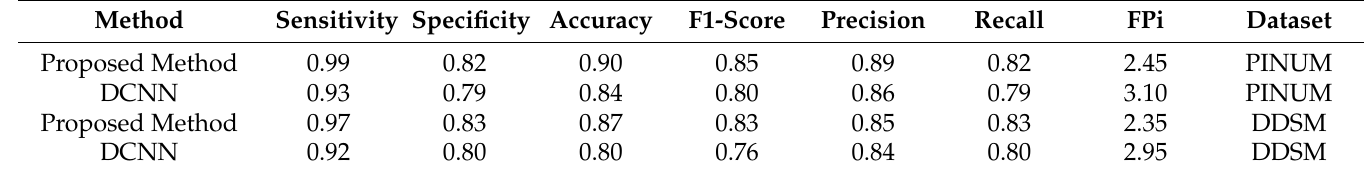
Table 4. Performance evaluation of the proposed method and the